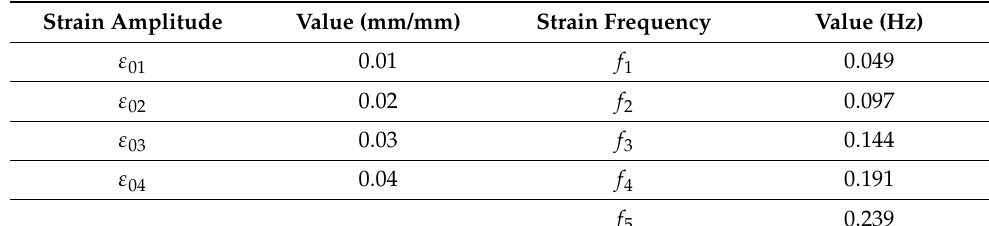
Table 4. Cyclic test